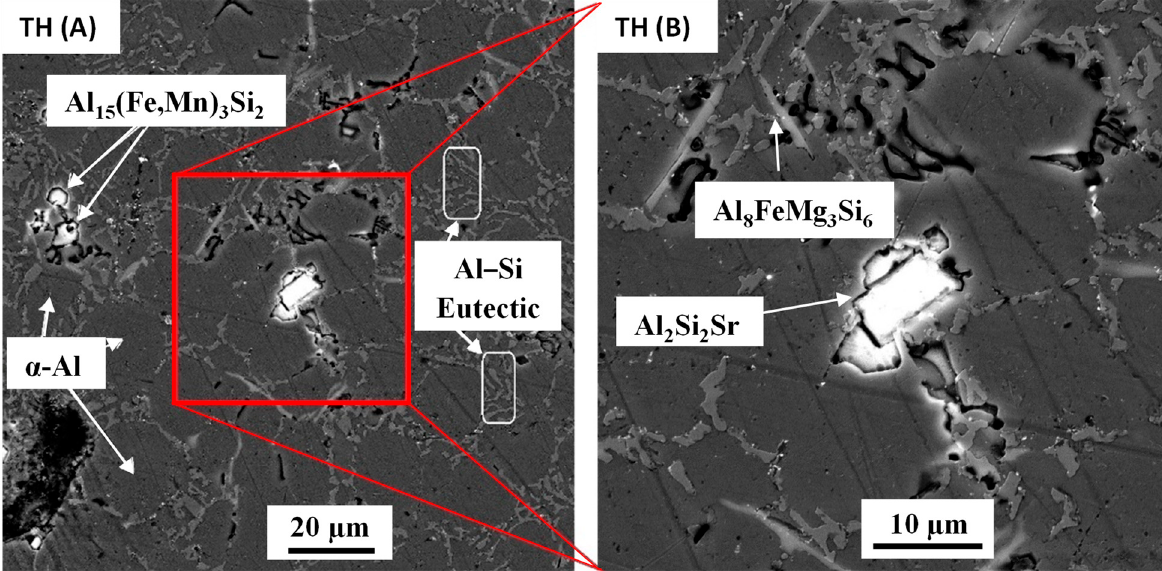
Figure 7. Micrograph showing the TH specimen: ( A ) representative primary phases; ( B ) close-up of the red box region in ( A ).